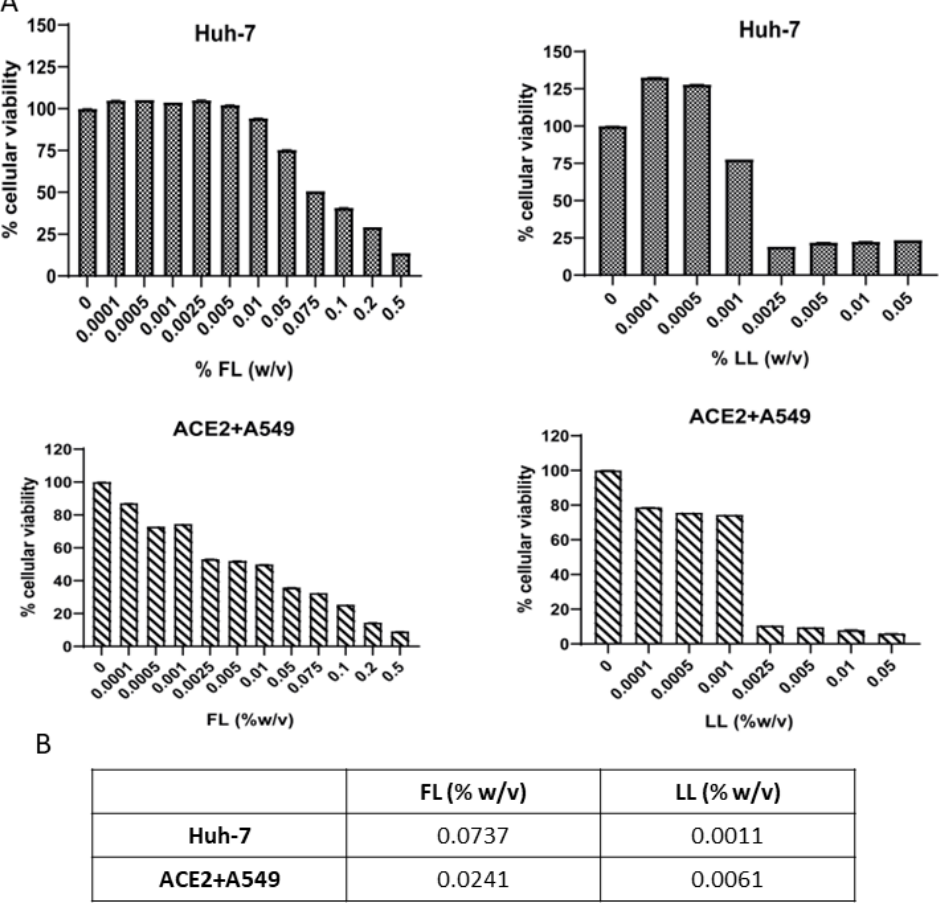
Figure 1. Viability of Huh ‐ 7 and ACE2+A549 cells exposed to FL and LL. Cells were cultured in culture medium and treated or mock ‐ treated for 48 h with a range of concentrations of the compounds. ( A ) Cell viability was measured by the MTT tetrazolium salt assay and calculated as the percentage of viability compared to untreated cells; columns represent the mean viability ± S.D. ( n = 8) after exposure to the drugs. ( B ) CC50 values for each compound and cell line. EC50 values were determined by a non ‐ linear fit model with variable response curve (four